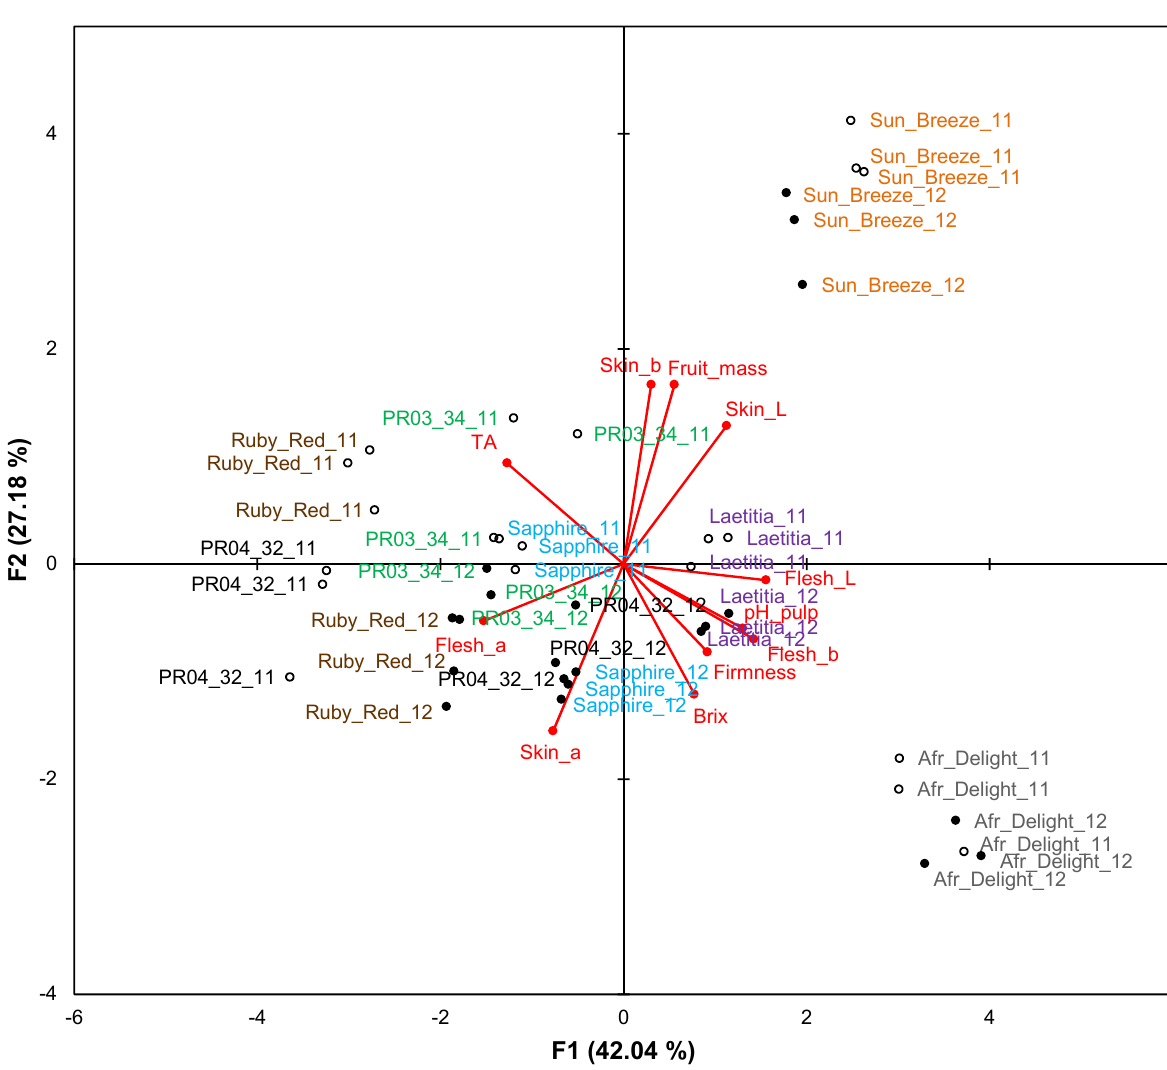
Figure 3. Principal component biplot of fruit attributes of ripe fruits from South African plum ( Prunus salicina Lindl.) cultivars and selections of two consecutive harvest seasons. (axes F1 and F2: 69.22